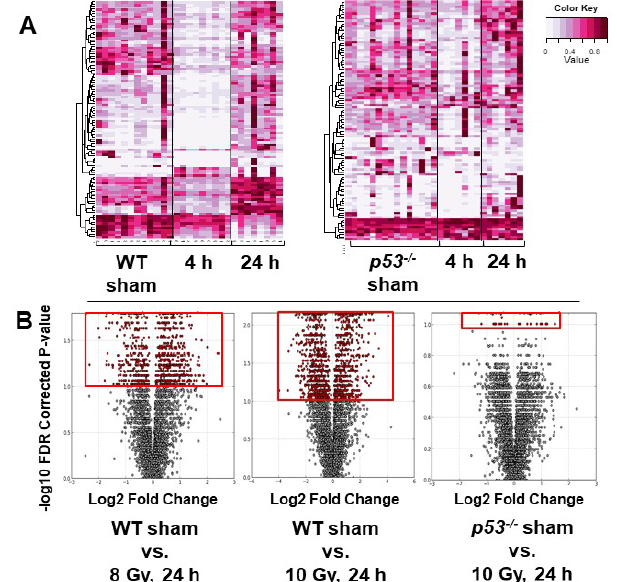
Figure 1. ( A ) Heatmaps generated by the machine-learning algorithm Random Forests of the top 100 ions at 4 and 24 h after 8 Gy total body irradiation for wild-type (WT) mice and at 4 and 24 h after 10 Gy for p53 − / − mice. More pronounced fold decreases of ions were observed at 4 h in WT compared to p53 − / − . ( B ) Volcano plots generated from MetaboLyzer at 24 h post-irradiation for WT (8 and 10 Gy) or p53 − / − (10 Gy) mice. Red inserts highlight the increased number of significant spectral features, showing higher perturbation in WT after a 10-Gy ionizing radiation (IR) dose compared to 8 Gy. Fewer significant ions were present in p53-deficient mice.